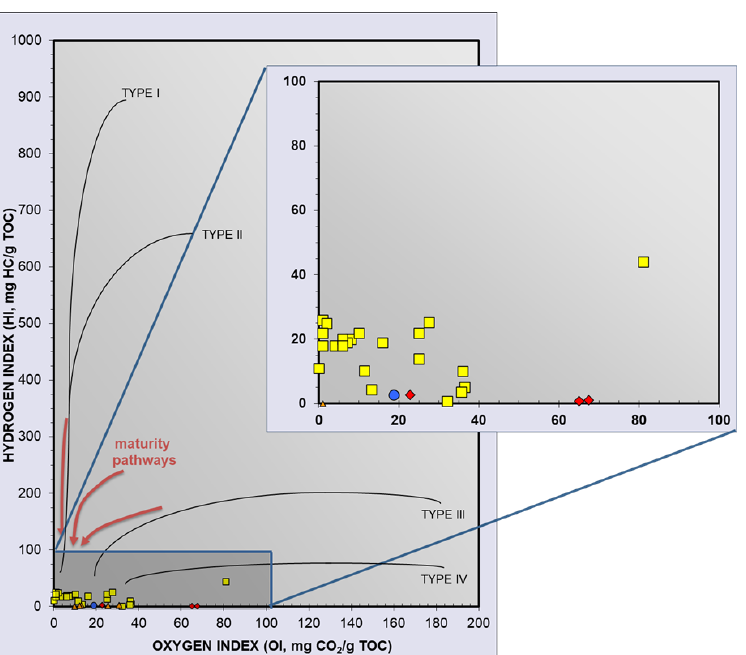
Figure 5. Van Krevelen-type diagram showing the relationship between the hydrogen index (HI) and oxygen index (OI) of the studied samples. Yellow squares representing Brejeira Fm., red diamonds Mira Fm., and blue circle Mértola Fm.